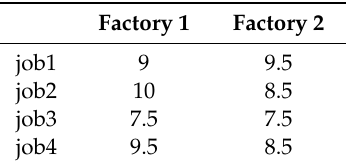
Table 4. Average processing time of each job in two